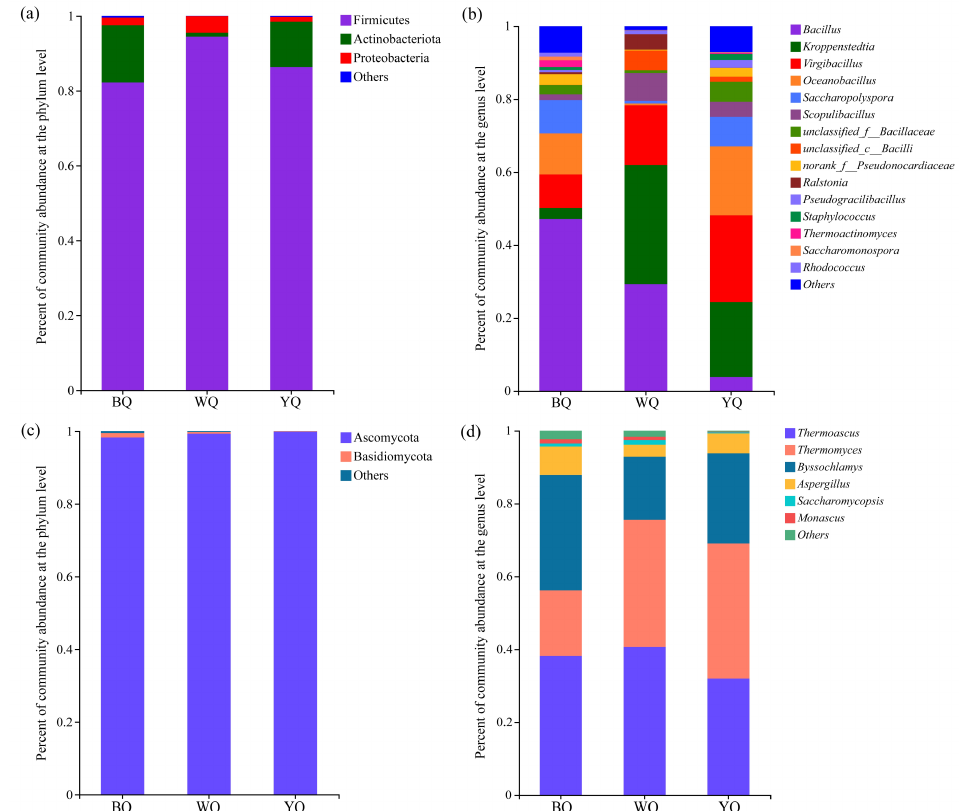
Figure 3. Microbial community composition of each sample. ( a ) Diagram for the bacteria according to the phylum level. ( b ) Diagram for the bacteria according to the genus level. ( c ) Diagram for the fungi according to the phylum level. ( d ) Diagram for the fungi according to the genus